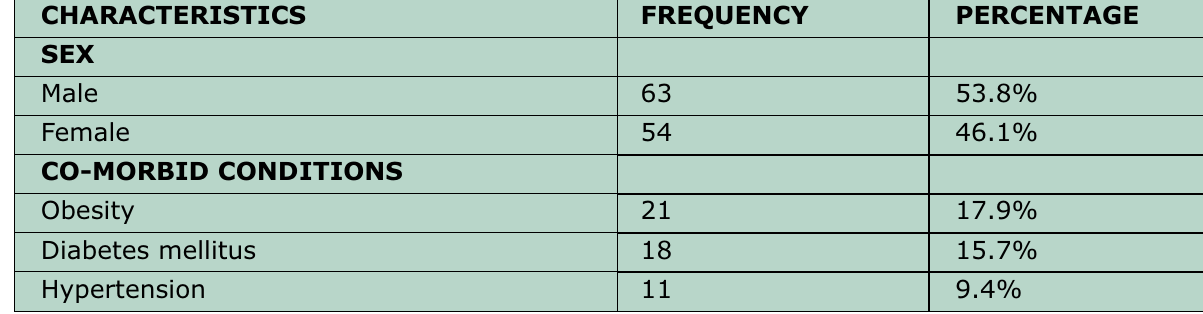
Table-I.  Demographic profile (n=117).